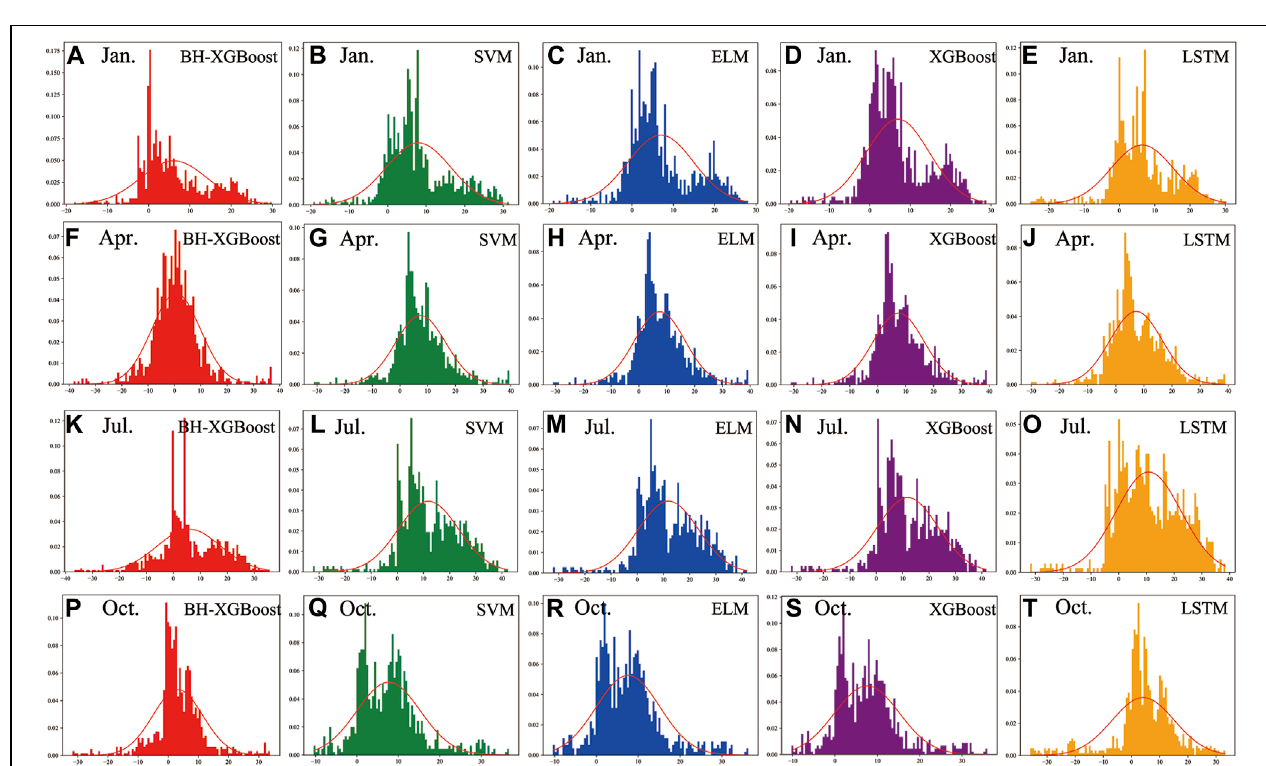
FIGURE 7 | The residual distribution of the different methods for different cases: (A–E) for Jan., (F–J) for Apr., (K–O) for Jul., (P–T) for Oct.